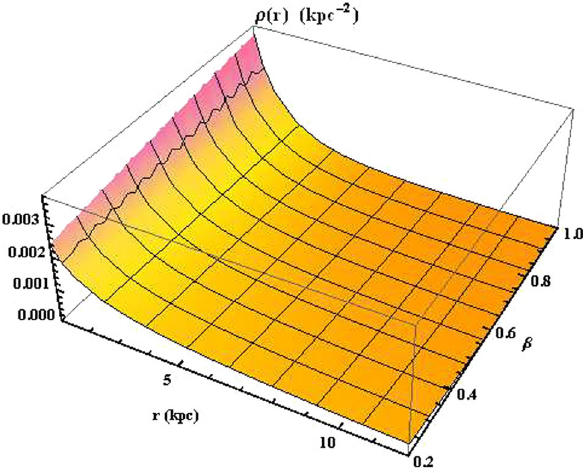
Fig. 2 The shape function b ( r ) is plotted with respect to the radial coordinate r corresponding to the parameters ρ 0 = 0 . 004 kpc − 2 , α = 0 . 5 , β = 0 . 8 , r th = 1 kpc and r 0 = 2